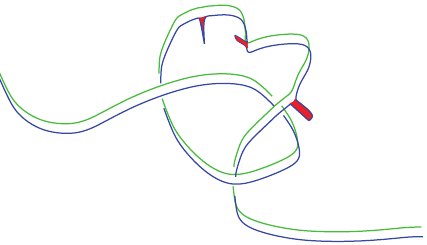
Figure 3.6. The green curve is the denoised version of the blue, where we have translated the green to make visualization easier.